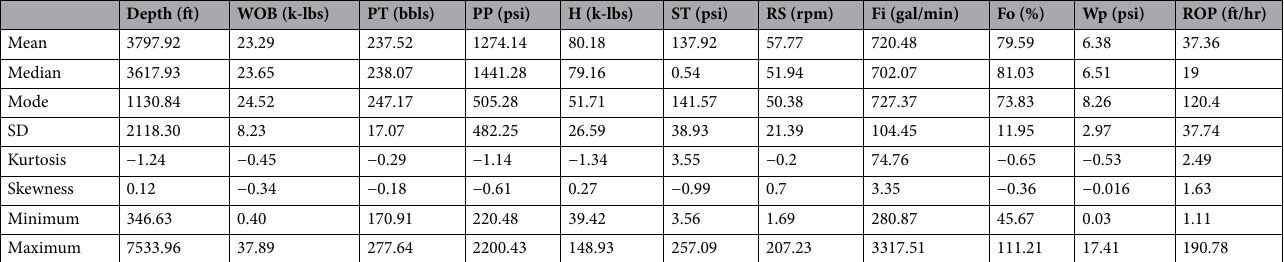
Table 2. Statistical parameters of the inputs and output